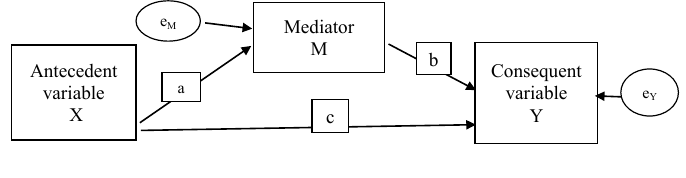
Fig. 1 – The statistical model 4 in the Hayes Process. Source: Darlington & Hayes